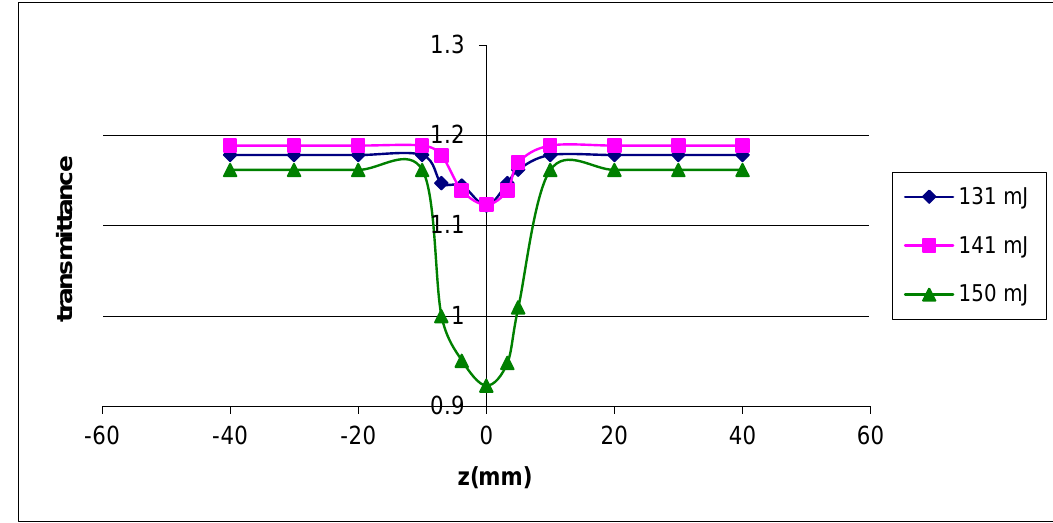
Fig .3: Open-aperture of a thin film for (131, 141 and 150) mJ at 1064